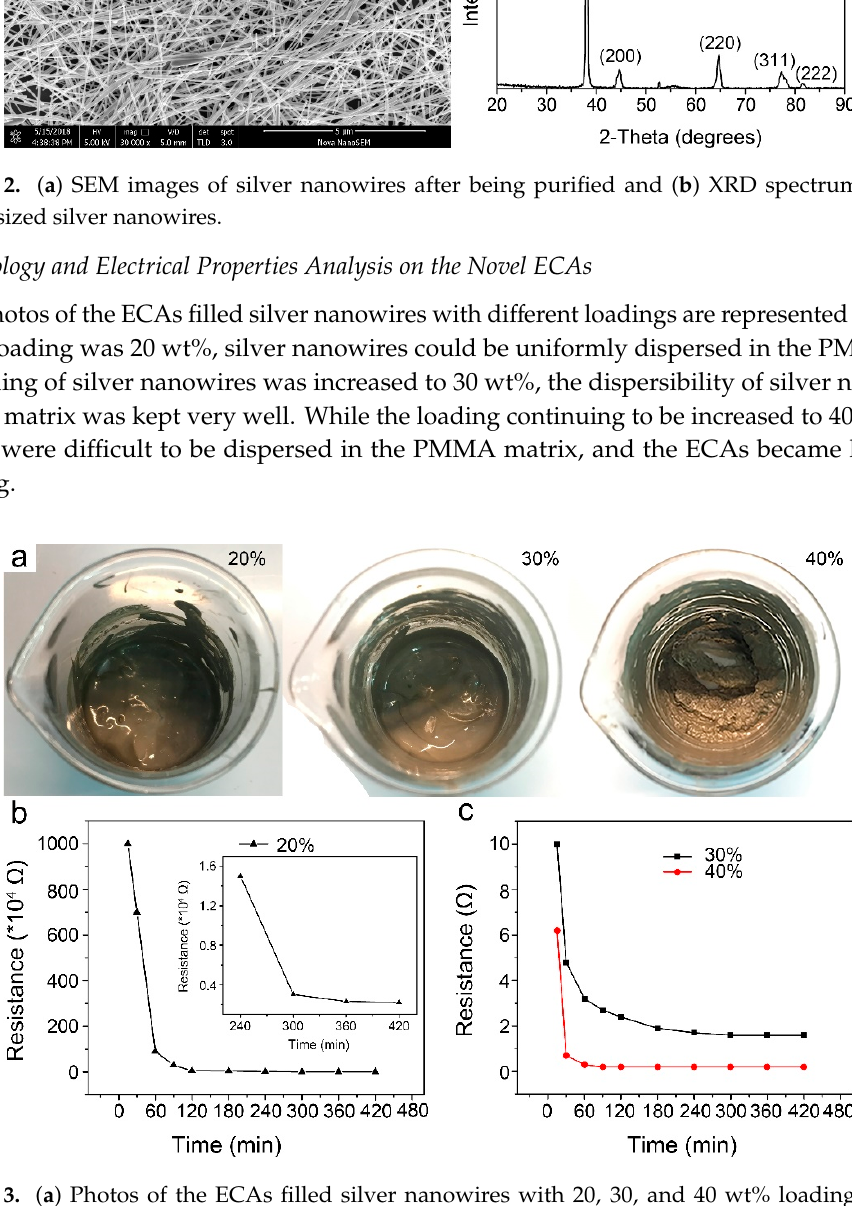
4 of 11 Figure 1. Schematic images of the TSVs fabrication process. 2.5. Characterizations SEM images were collected on a FEI Nova NanoSEM 650 field emission scanning electron microscope (FEI Co., Hillsboro, OR, USA) operating at 15 kV accelerating voltage. Optical images were collected on a VHX-5000 super depth of focus microscope (KEYENCE, Osaka, Japan). ICP-AES (Atomscan Advantage, Thermo Jarrell Ash, Waltham, MA, USA) was used to determine the concentration of silver. X-Ray Diffraction (XRD) characterization was performed using a X'Pert Pro X-ray diffractometer (PANalytical B.V., Almelo, The Netherlands) with a monochromatized Cu K α radiation source and a wavelength of 0.1542 nm. The sheet resistance of silver nanowires ECAs coated on a glass slide was measured on a Leihighton 1510EB Non-Contact Resistivity Measurement System (Semilab LEI, Lehighton, PA, USA). The average thickness of a sample film was obtained with a KLA- Tencor P-7 stylus profiler (KLA-Tencor Co., Milpitas, CA, USA). A KEYSIGHT B29021 sourcemeter (KEYSIGHT TECHNOLOGIES Co., Santa Rosa, CA, USA) attached to a LAB150 manual analytical probe station (Shenzhen zhanxin technology Co., Ltd, Shenzhen, China) was used for electrical characterization of fully filled TSVs. 3. Results and Discussion 3.1. Characterization of Silver Nanowires Figure 2a shows a typical SEM image of the synthesized silver nanowires. The inset is the local amplification image. The SEM images show that the as-prepared silver nanowires have a length of about 6~13 μ m and diameter of 50~90 nm. Rare Ag nanoparticles were observed in Figure 2a (purity > 95%). Moreover, through purifying silver nanowires using the vacuum filtration method, the